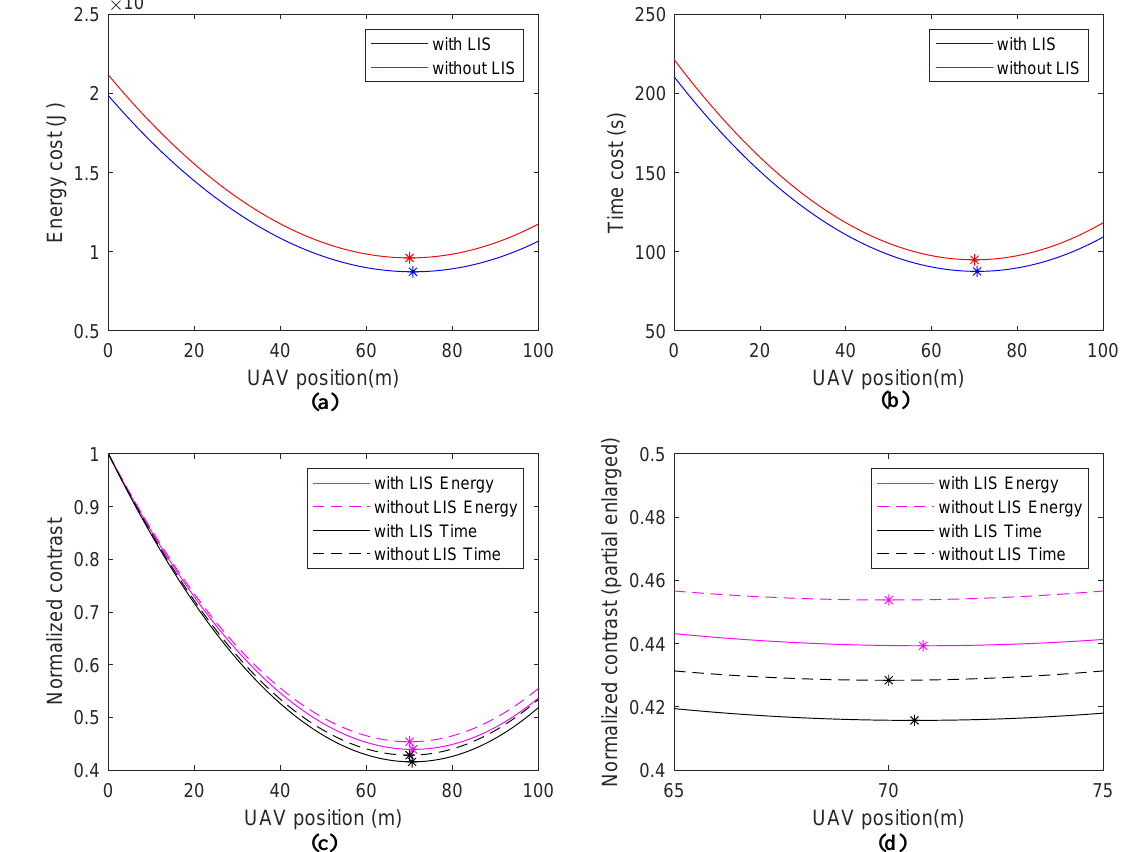
Figure 7. Simulation results of Scene I : ( a ) energy cost, ( b ) time cost, ( c ) normalized contrast, and ( d ) normalized contrast (partial